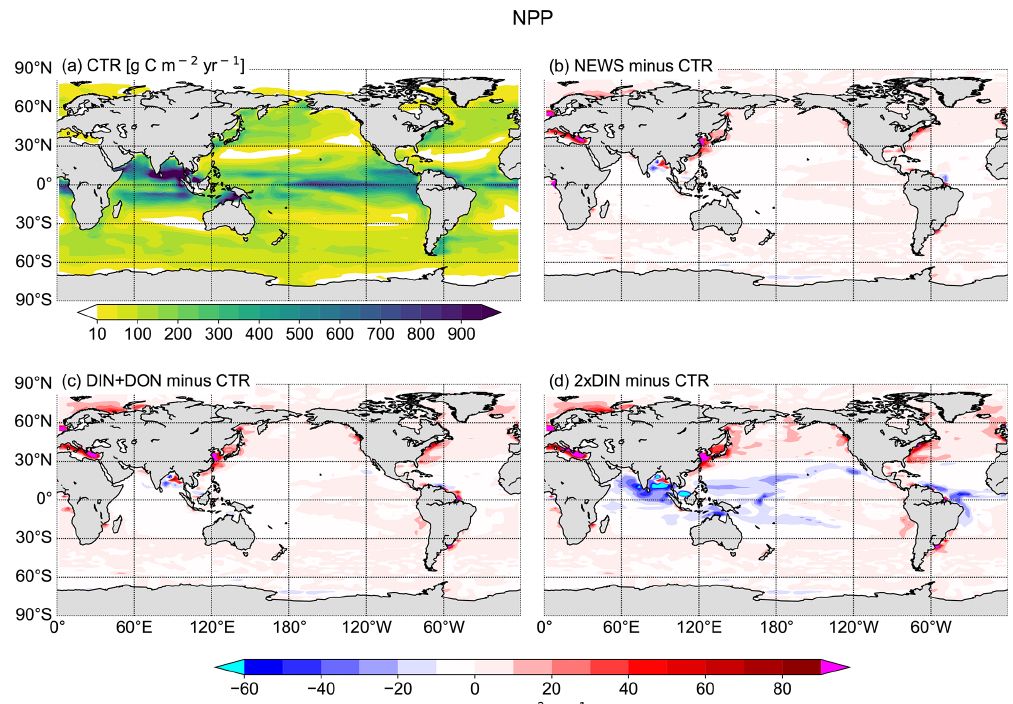
Figure 12. (a) Annual vertically integrated rates of primary production (NPP) calculated from UVic CTR in gCm − 2 yr − 1 . (b–d) Differences in NPP distribution calculated from different UVic simulations with riverine N export and from UVic simulation without riverine nutrient input (CTR) in gCm − 2 yr − 1 . (b) NPP from NEWS with riverine DIN. (c) NPP in the simulation with riverine DIN and DON. (d) NPP in the simulation with twice the amount of DIN. The extreme values shown in cyan and magenta in these panels are listed in Table